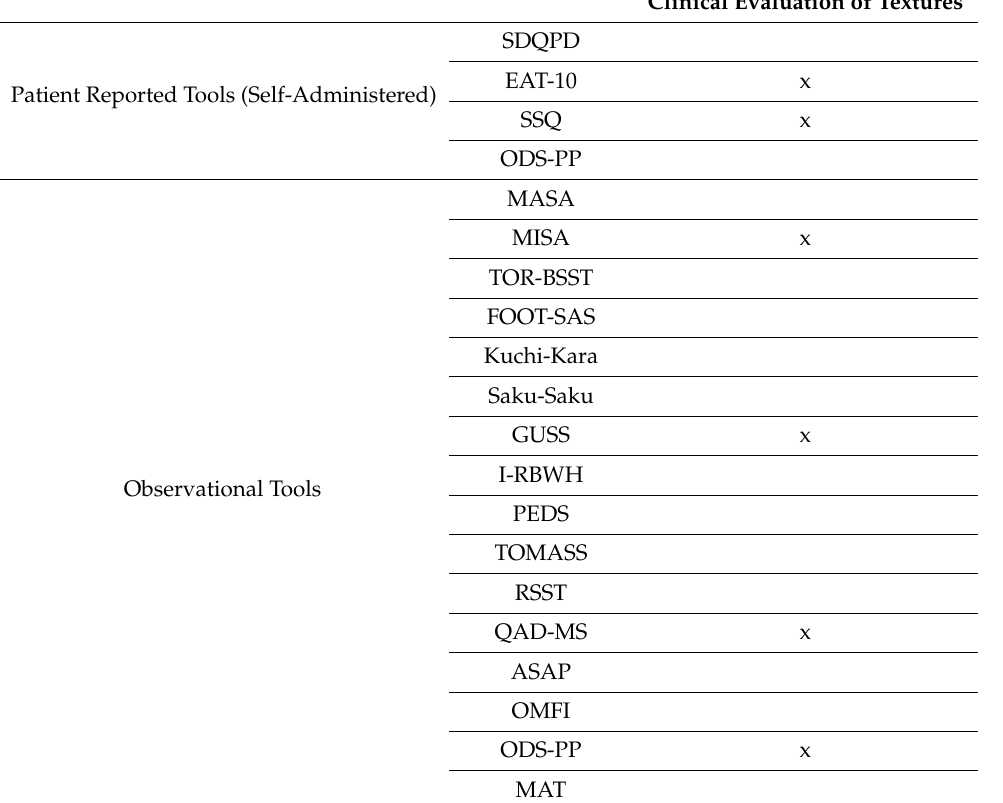
Table 3. Categorization of OD